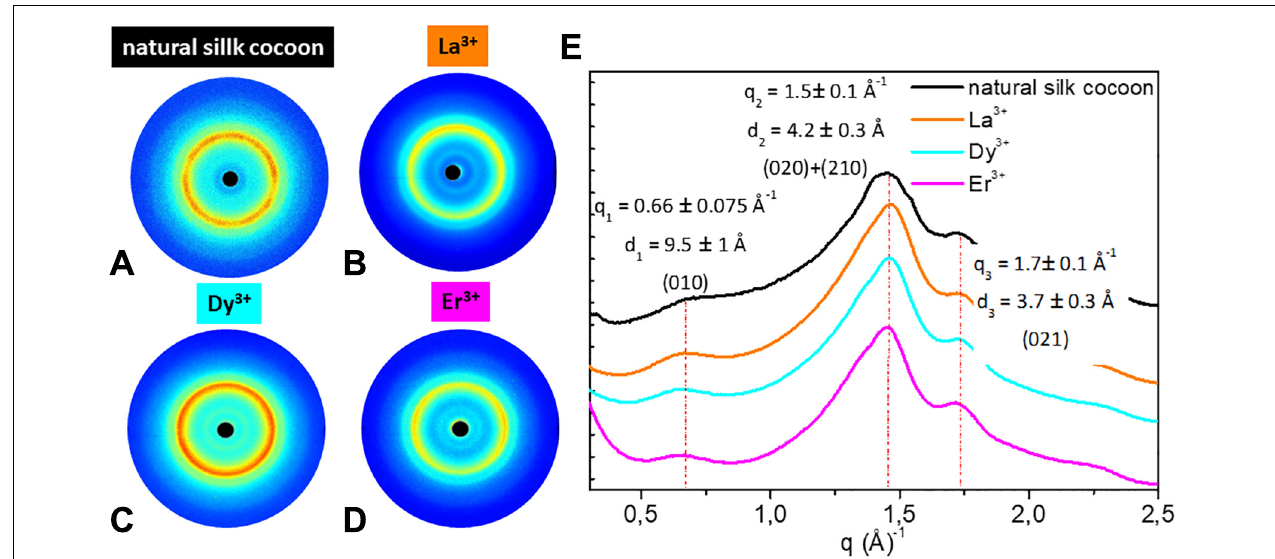
FIGURE 5 | 2D WAXS patterns of (A) natural silk cocoon and regenerated fibers obtained after treatment with (B) La + 3 ; (C) Dy + 3 ; (D) Er + 3 respectively; (E) corresponding 1D WAXS patterns with vertical bars highlighting the reflections at q 1 = 0.66 ± 0.075 Å − 1 (d 1 = 9.5 ± 1 Å), q 2 = 1.5 ± 0.1 Å − 1 (d 2 = 4.2 ± 0.3 Å), and q 3 = 1.7 ± 0.1 Å − 1 (d 3 = 3.7 ± 0.3 Å). These peaks were indexed as follows: q 1 the (010) reflection; q 2 an overlap of the (020) and (210) reflections; q 3 the (021)